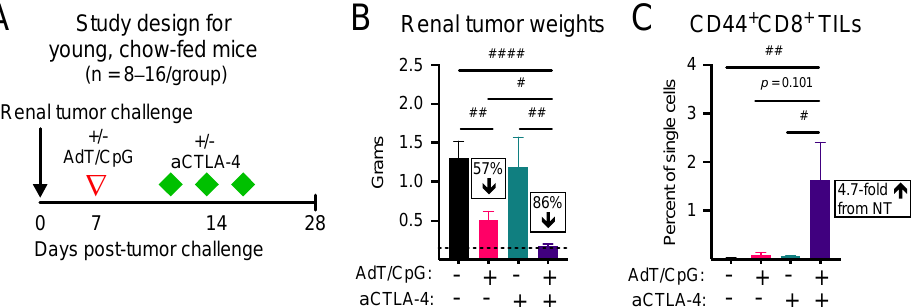
Figure 1. Combinatorial therapy induces the greatest reduction in tumor growth and expansion of CD44 + CD8 + tumor-infiltrating lymphocytes (TILs) in young, chow-fed mice. ( A ) Experimental design. ( B ) Tumor weights and ( C ) CD44 + CD8 + TILs at day 28 post-tumor challenge. Percent change compared to no therapy control. # denotes non-parametric test. # p < 0.05, ## p < 0.01, #### p < 0.0001. NT: no therapy.